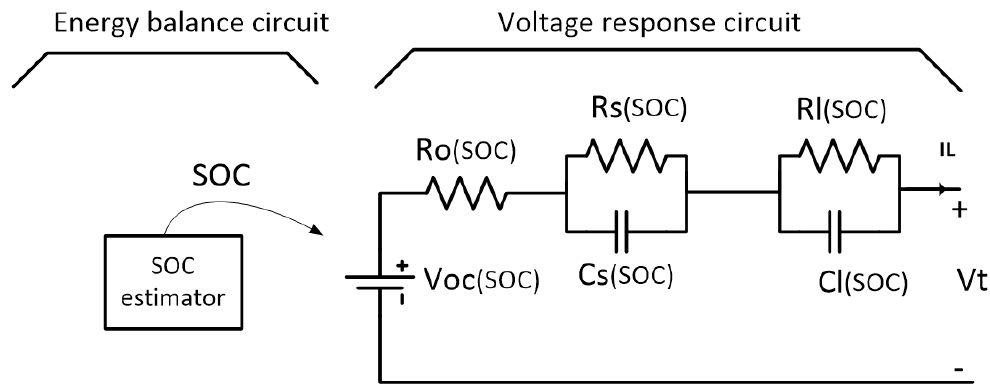
Figure 1. Schematic diagram of the hybrid electrical